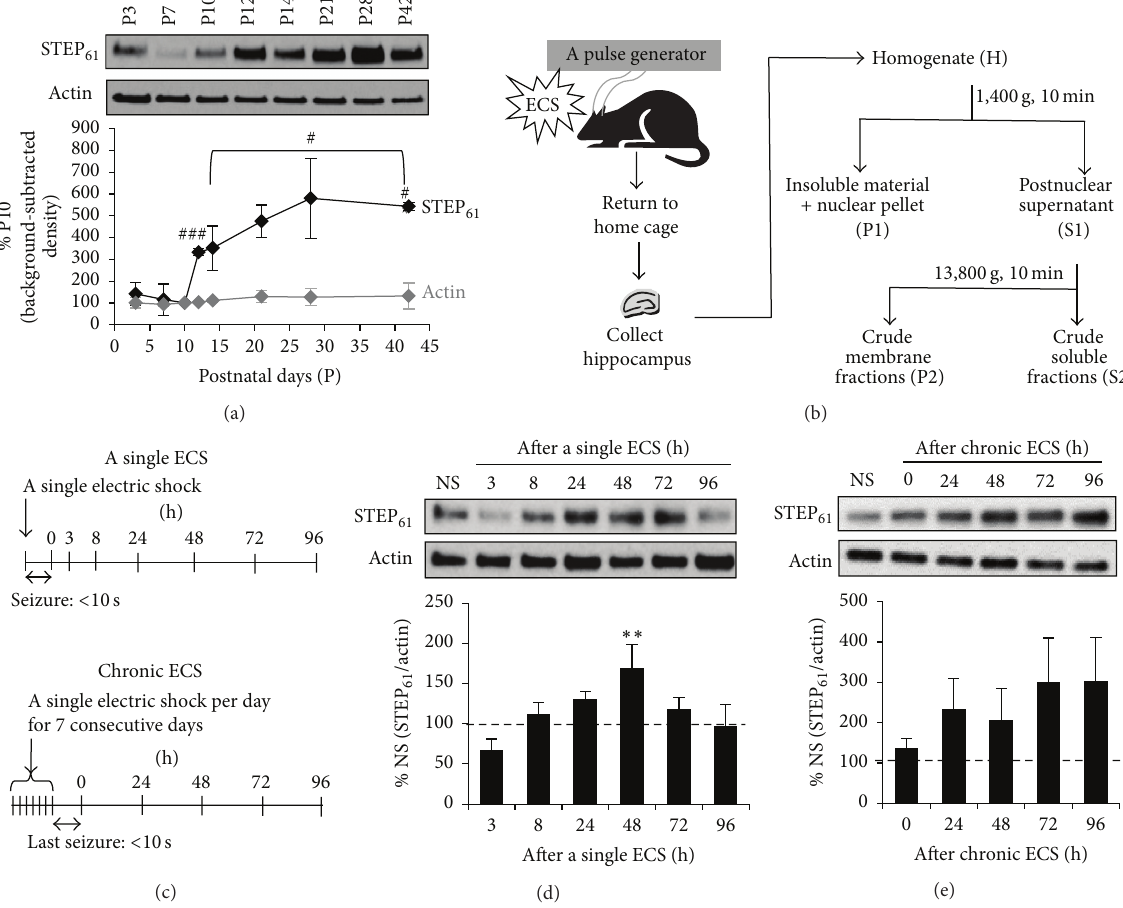
Figure 1: A single ECS but not chronic ECS transiently increases membrane-associated STEP 61 expression in the hippocampus. (a) Hippocampal expression of STEP 61 during postnatal development. Immunoblot analysis and quantification of STEP 61 and 𝛽 -actin from the crude membrane (P2) fractions of rat hippocampi were obtained at postnatal days (P) 3, 7, 10, 12, and 14 ( 𝑛 = 3 rats per time point) and 21, 28, and 42 ( 𝑛 = 2 rats per time point). Background-subtracted western blot band intensities of STEP 61 and 𝛽 -actin were normalized to those of P10 group, which was taken as 100%. STEP 61 expression significantly increased from P10 to P12 by 3-fold ( ### 𝑝 < 0.005 , 𝑡 -test) and to P42 by 5-fold ( # 𝑝 < 0.05 , 𝑡 -test). (b) Schematic workflow of an experiment from ECS induction in rats to biochemical fractionation of their hippocampi. (c) Schematic experimental design of a single ECS and chronic ECS (a single ECS per day for 7 consecutive days). (d-e) Immunoblot analysis of STEP 61 in the hippocampal crude membrane (P2) fraction following a single ECS ((d) 𝑛 = 5 rats per time point) and chronic ECS ((e) 𝑛 = 6 rats per time point). Time points shown represent the duration after the induction of a single ECS (d) or chronic ECS (e) prior to brain removal. The ratio of the STEP 61 band intensity over the 𝛽 -actin band intensity was calculated per each time point and normalized to the ratio of “no seizure” (NS) sham group, which was taken as 100%. Data shown represent the mean band intensity ± SEM. (c) A single ECS transiently increases STEP 61 expression in the hippocampus ( ∗∗ 𝑝 < 0.01 ). (d) Chronic ECS does not significantly alter STEP 61 expression in the